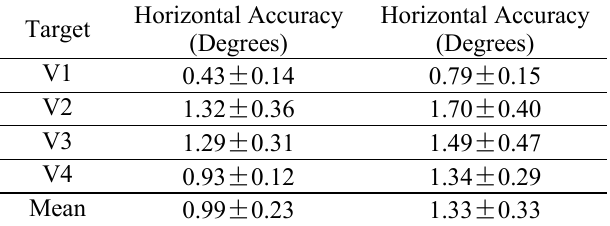
Table 3 Average accuracy in horizontal and vertical directions.